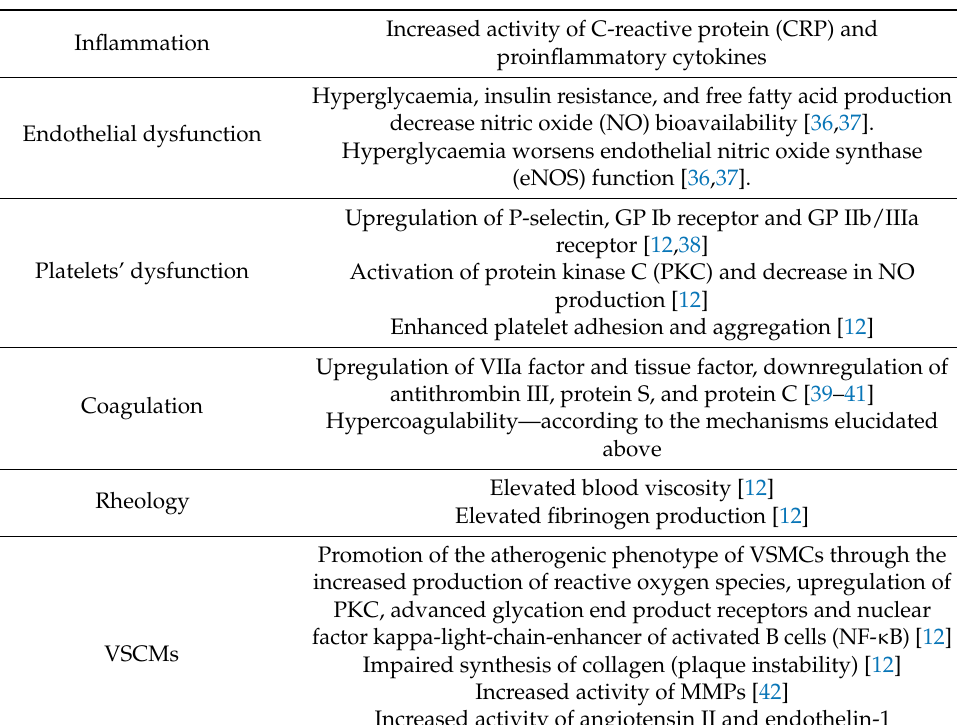
Table 3. The most important atherogenic mechanisms in patients with